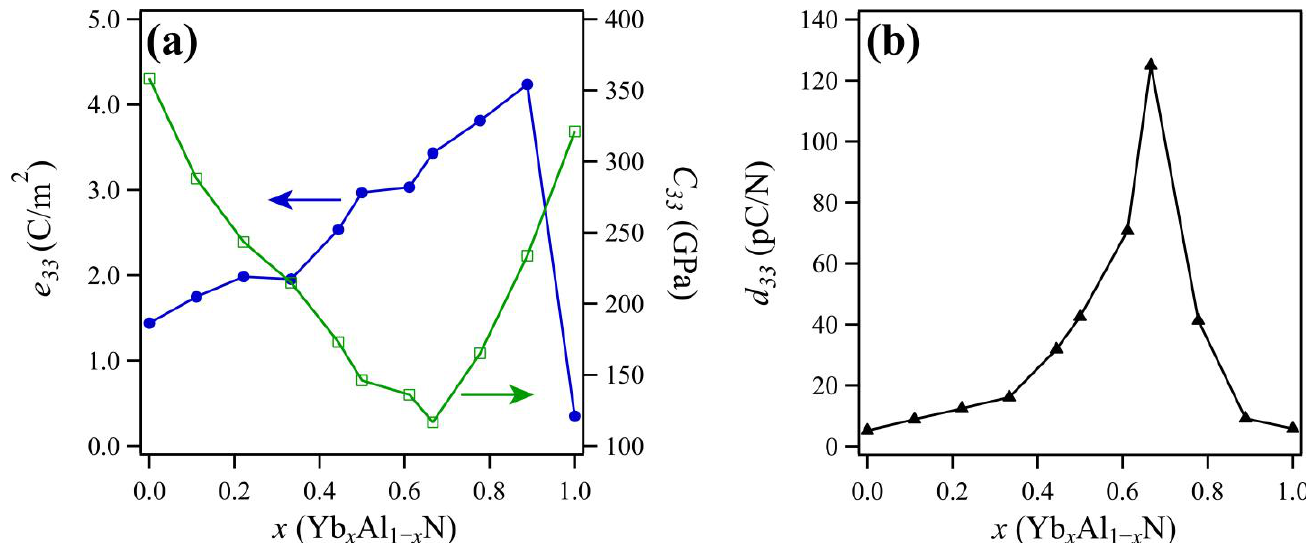
Figure 4. ( a ) Calculated piezoelectric stress constant, e 33 (blue line), and elastic constant, C 33 (green line) of Yb x Al 1−x N as a function of Yb content; ( b ) calculated piezoelectric constant, d 33 , of Yb x Al 1−x N as a function of Yb content.